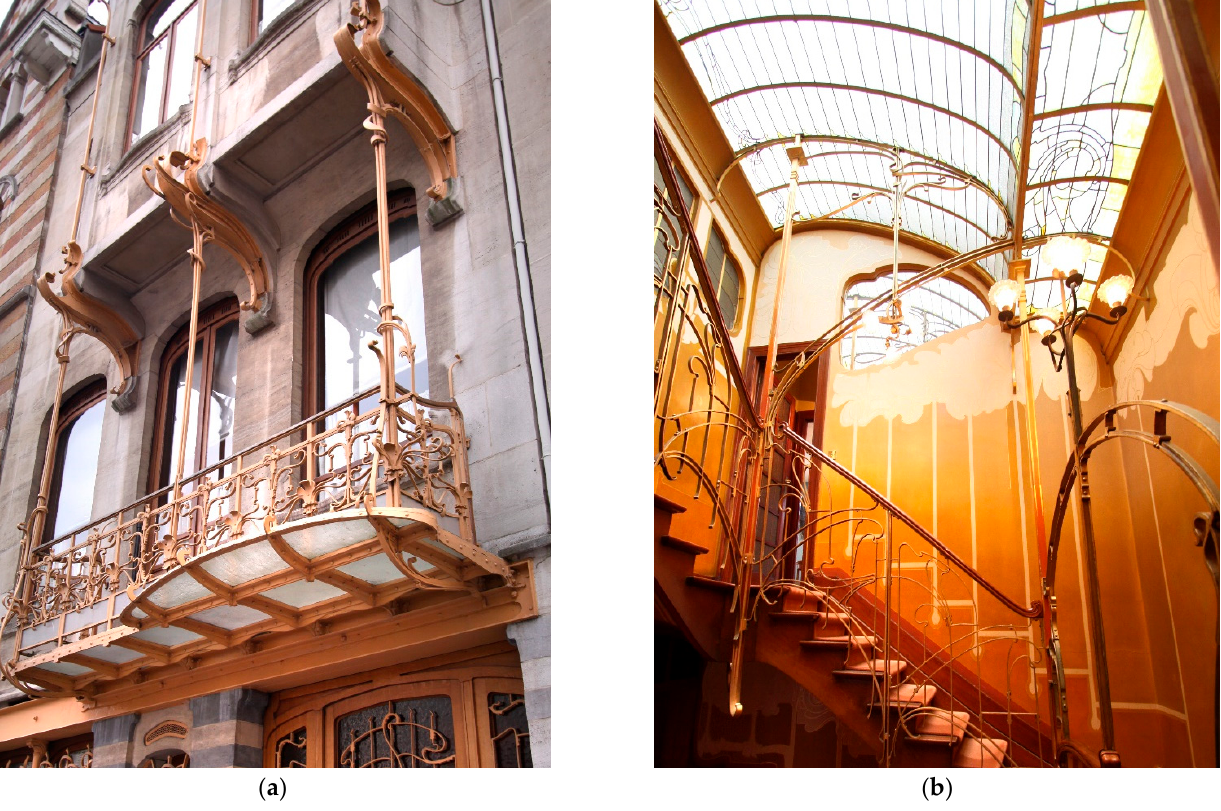
Figure 10. The natural colors and biomorphic structural forms in the Horta House: ( a ) The balcony; ( b ) the skylight.